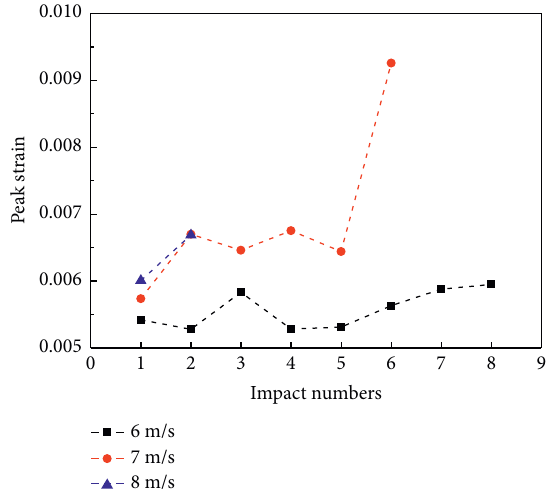
Figure 6: Peak strain with the increase of impact numbers under diferent impact